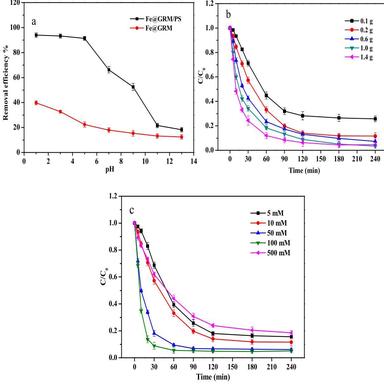
The effect of the initial pH on (a); the dosage of the Fe@GRM (b); and PS concentration (c) for AO7 removal.